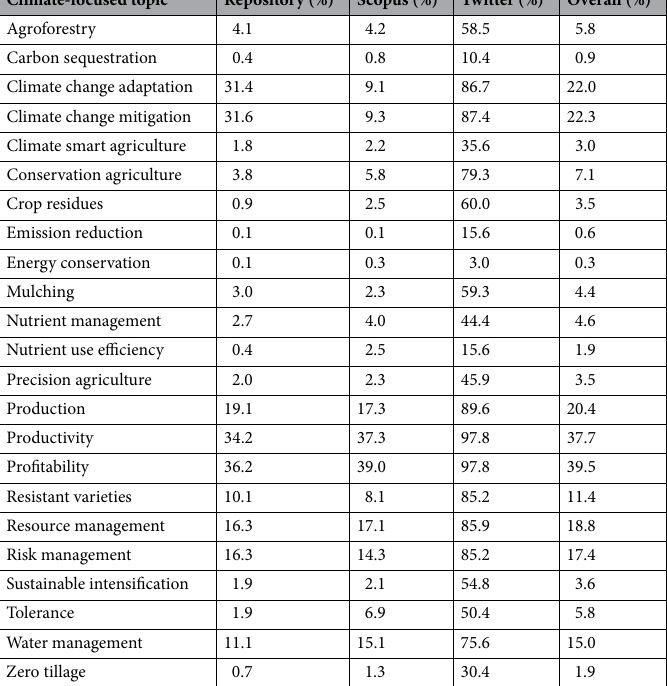
Table 2. Distribution of climate-focused topics identified in the